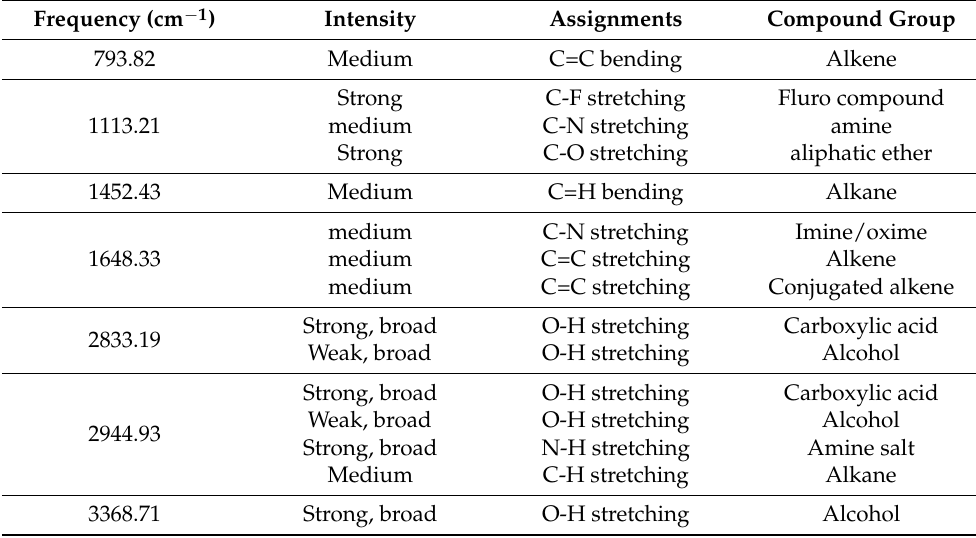
Table 5. Fourier Transform Infrared Spectrometer (FTIR) spectrum analysis for the methanolic extract of A. johnwoodii